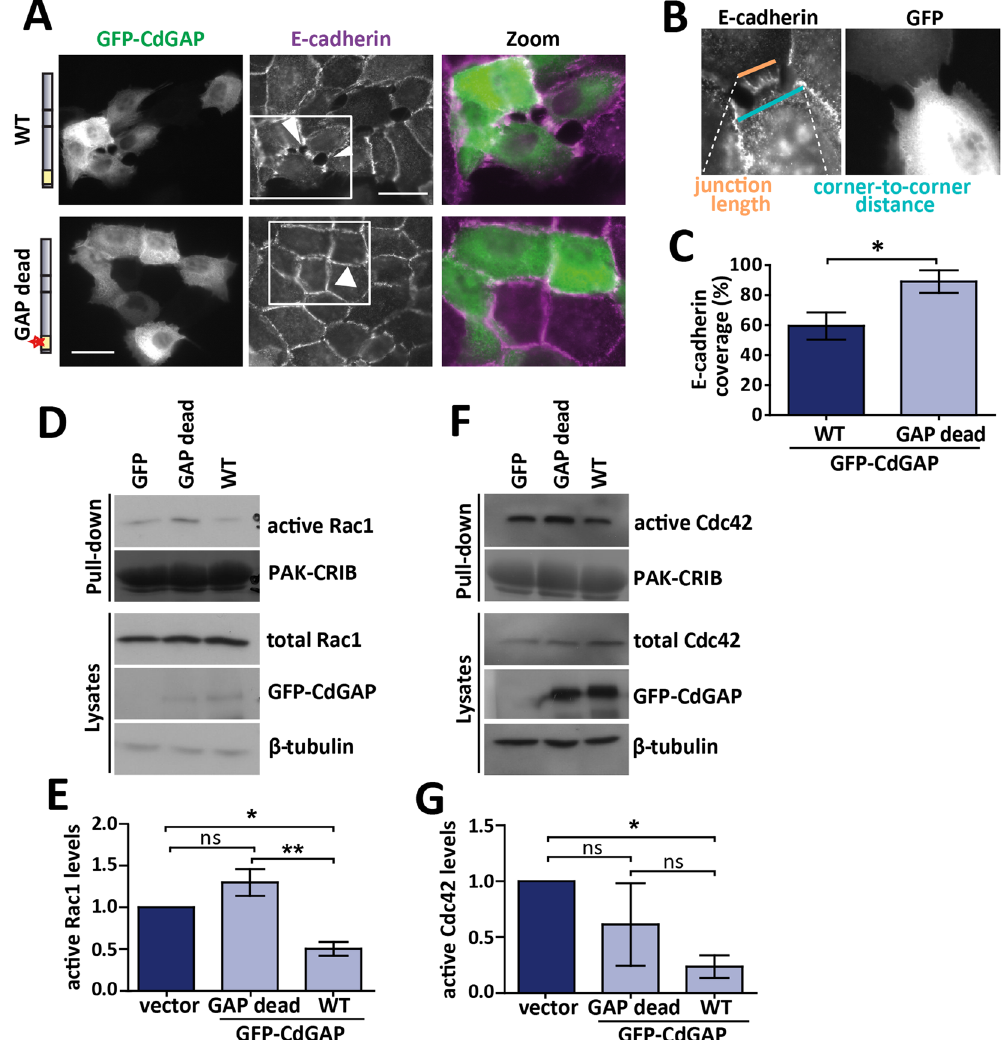
Figure 2. CdGAP-mediated junction disruption is GAP-dependent. Full length GFP-CdGAP wild-type or a GAP-dead CdGAP (catalytic dead) were expressed in keratinocytes with mature junctions for 8 hours ( A – C ) or 24 hours ( D – G ). ( A ) Cells were fixed and stained for E-cadherin. Images were collected and colour images from each channel overlaid to create merged images (Zoom). Arrowheads show junctions with interrupted E-cadherin staining. ( B ) Method used to quantify junction disruption. A parameter “E-cadherin coverage” is defined as the proportion of the length (pixels) of contact interface between neighbouring cells (corner-to- corner; blue line) that is covered by E-cadherin staining (orange line). ( C ) Graph shows the average E-cadherin coverage values following expression of CdGAP wild-type or GAP-dead. Values of around 100% coverage represent control junctions where E-cadherin staining extends from corner-to corner of a cell-cell contact. ( D ) Lysates of keratinocytes expressing different constructs were incubated with immobilised GST-PAK-CRIB to detect active, GTP-bound Rac1 ( D ) or Cdc42 ( F , pull down). Total Rac1 or Cdc42 (2% total lysate volume), GFP-tagged CdGAP and β -tubulin were detected in the lysates. ( E + G ) Fold activation of Rac1 ( E ) or Cdc42 ( G ) was quantified by dividing the active GTPase level (pull down) by the total GTPase protein level (lysate) and normalising this to the value of the control (GFP-vector). Statistical significance was assessed using Student’s t-test ( C ) or one-way ANOVA with Bonferroni’s multiple comparison test ( E , G ). Standard error of the means is shown. Ns = not significant. * P ≤ 0.05, ** P ≤ 0.01. Scale bar = 50 µ m. N =